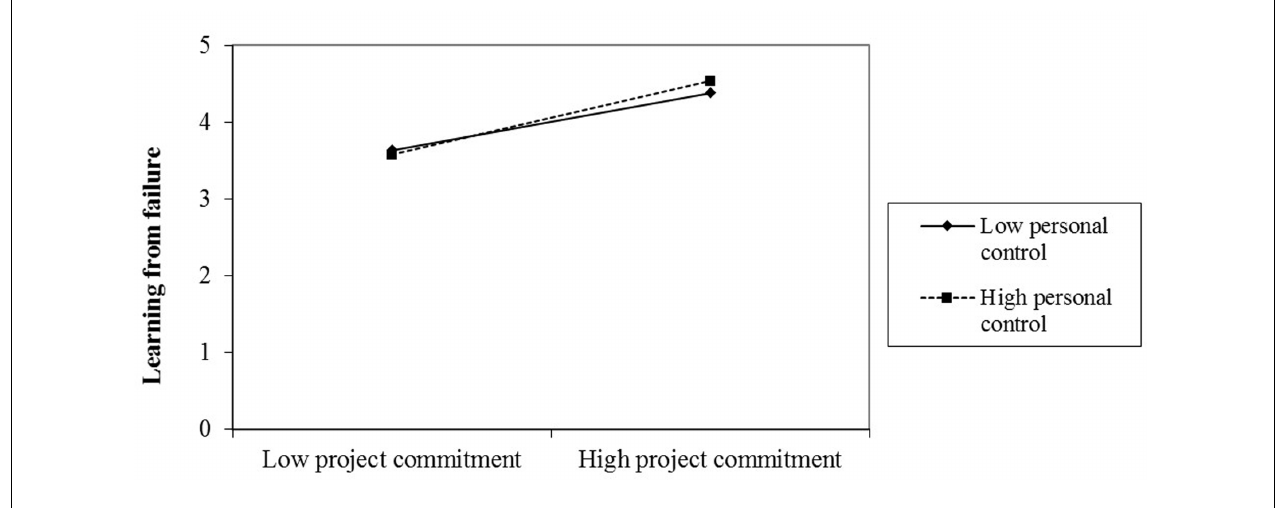
FIGURE 3 | The moderating effect of personal